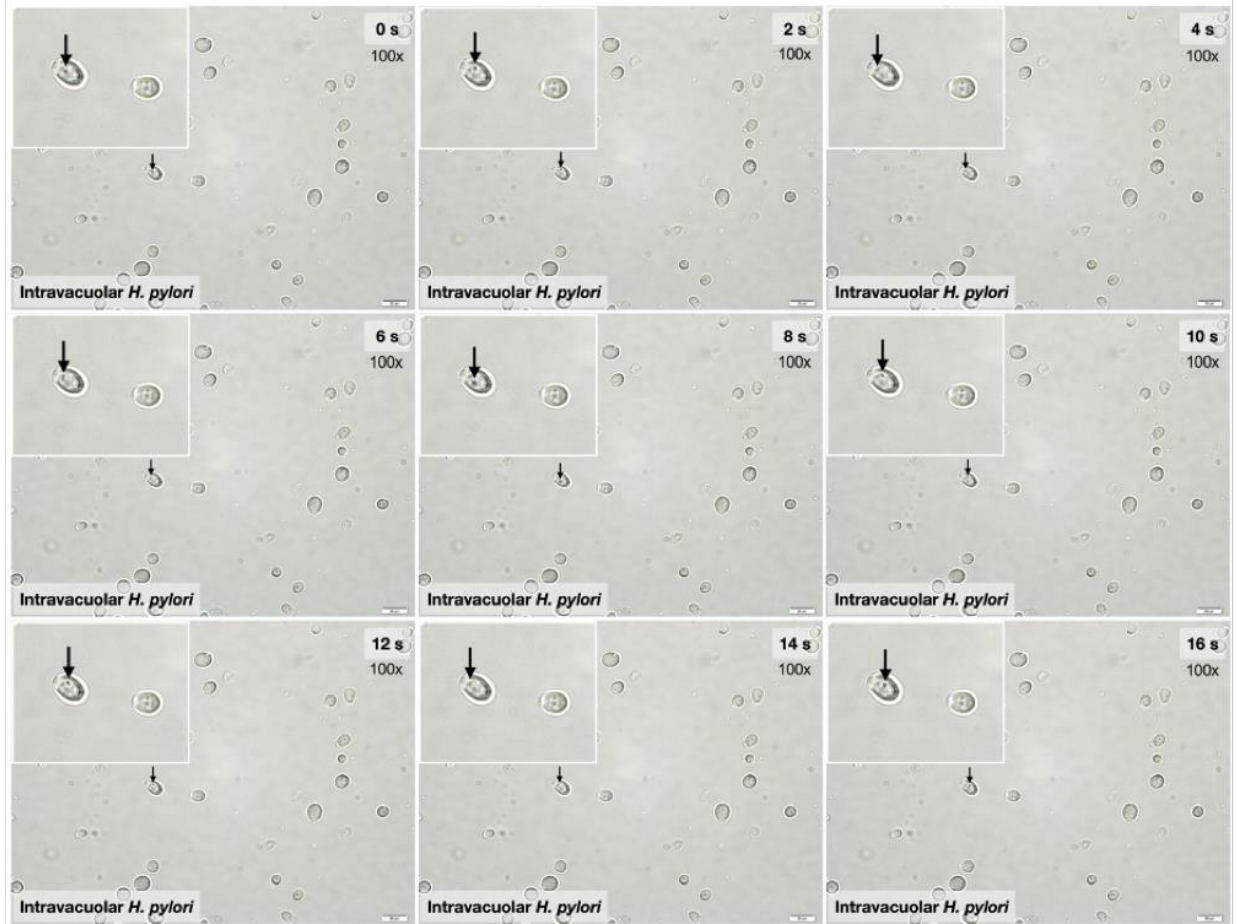
Figure 1. Characteristics of bacteria-like bodies (BLBs). The motile property of intravacuolar H. pylori in the cytosols of Candida yeast cells (BLBs) was demonstrated by the time-frame